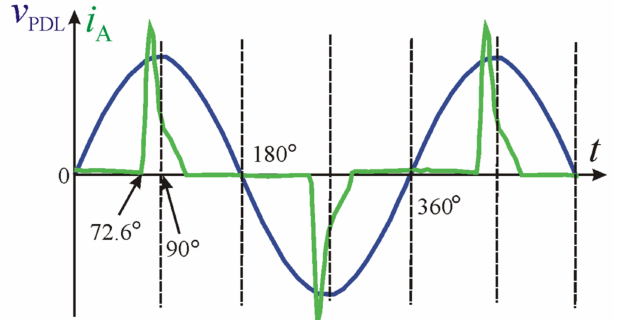
Figure 5. Current and voltage time diagrams at the point of connection of Siemens Micromaster 420 single-phase diode rectifier supply-side VFD to the PDL, with a motor supply voltage frequency of 50 Hz.